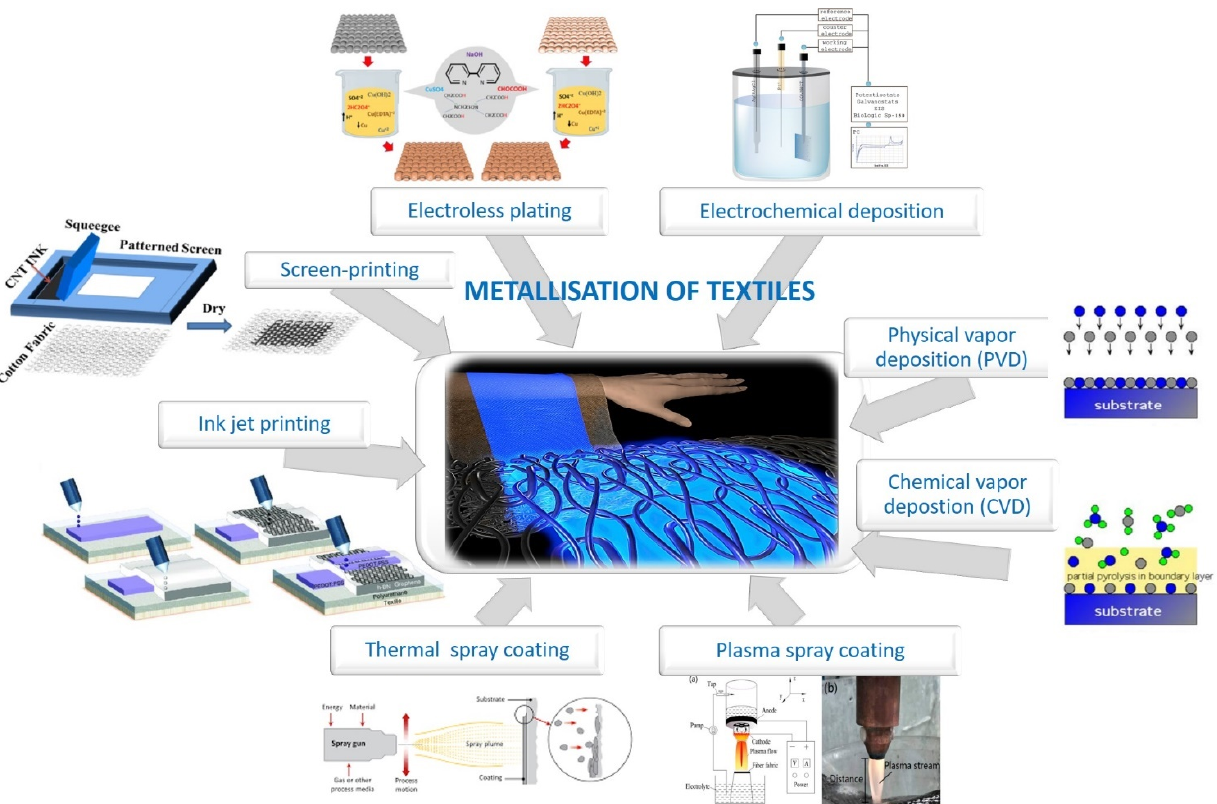
Figure 1. Schematic presentation of different metallization techniques to obtain electrically conductive textiles, namely, electroless plating (reprinted with permission from Ref. [6] Copyright 2021 Elsevier), electrochemical deposition (reprinted with permission from Ref. [27] Copyright 2021 Springer Nature), physical and chemical vapor deposition, thermal and plasma spray coating (reprinted with permission from Ref. [28] Copyright 2021 MDPI), inkjet (reprinted with permission from Ref. [29] Copyright 2021 Springer Nature), and screen-printing (adapted from Ref. [30]).